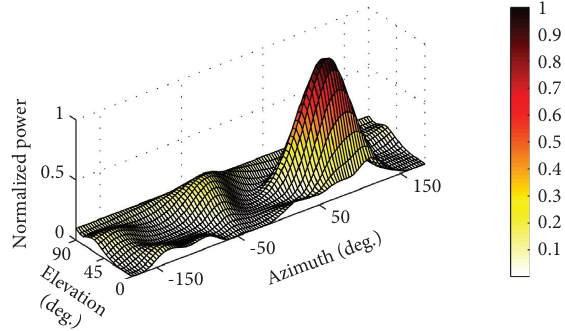
Figure 6: Normalized power pattern: proposed null steering.